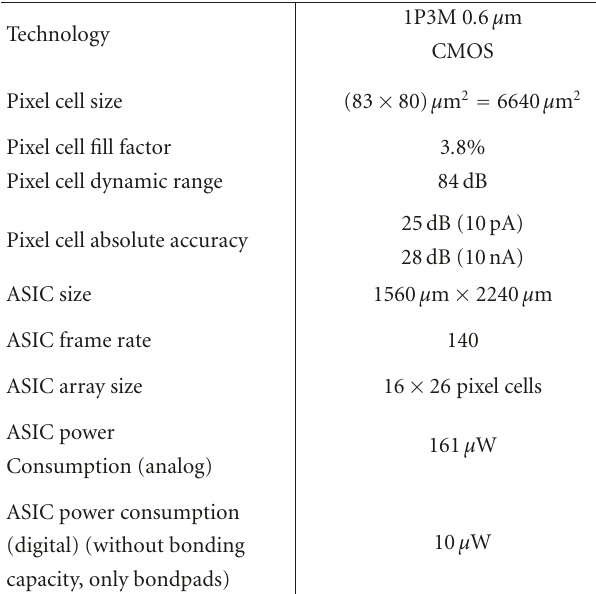
Table 1: (Simulated) characteristics of the LOC pixel cell/sensor ar-